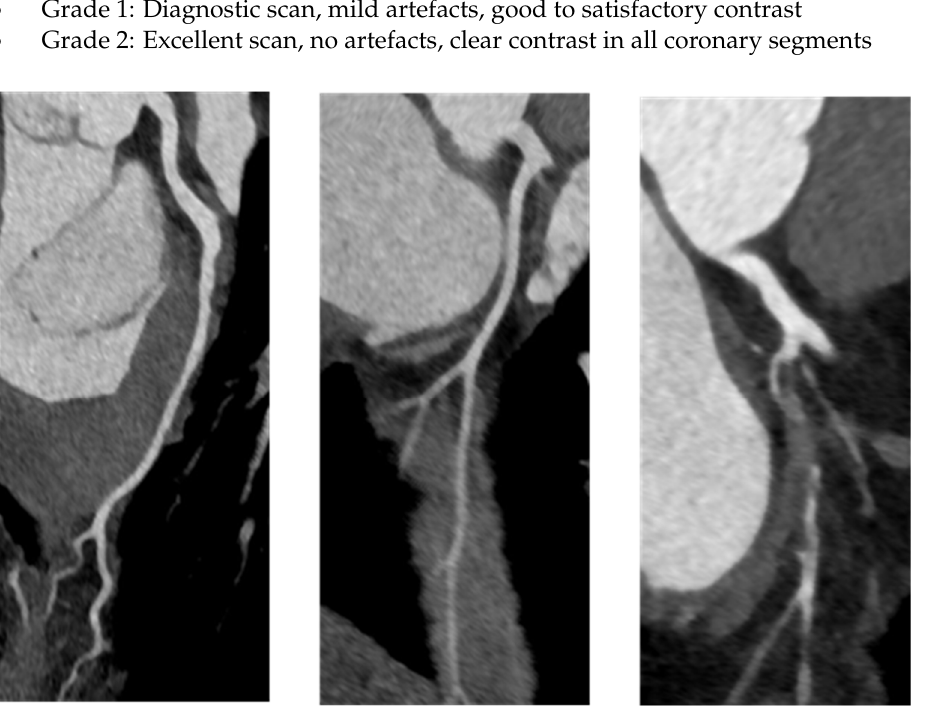
Figure 1. Rating score for the image quality of coronary arteries using curved planar reformations. From left to right: grade 2—excellent (good interpretability in all coronary segments); grade 1— diagnostic (reduced interpretability of at least one coronary segment); grade 0—non-diagnostic (at least one coronary segment is not interpretable).